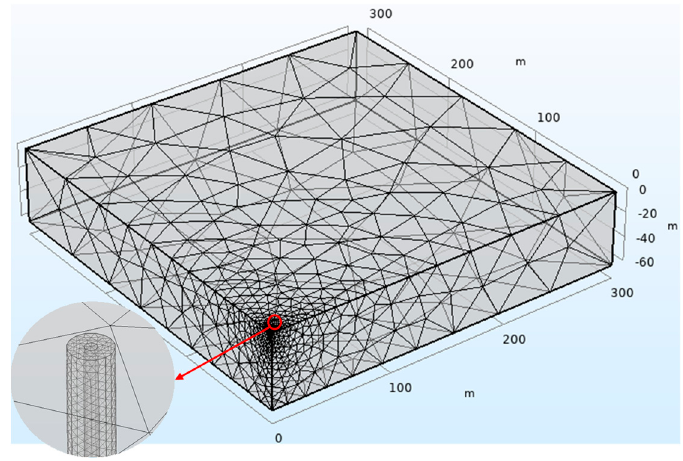
Figure 5. Computational domain, with mesh, for the 2 × 2 borefield.